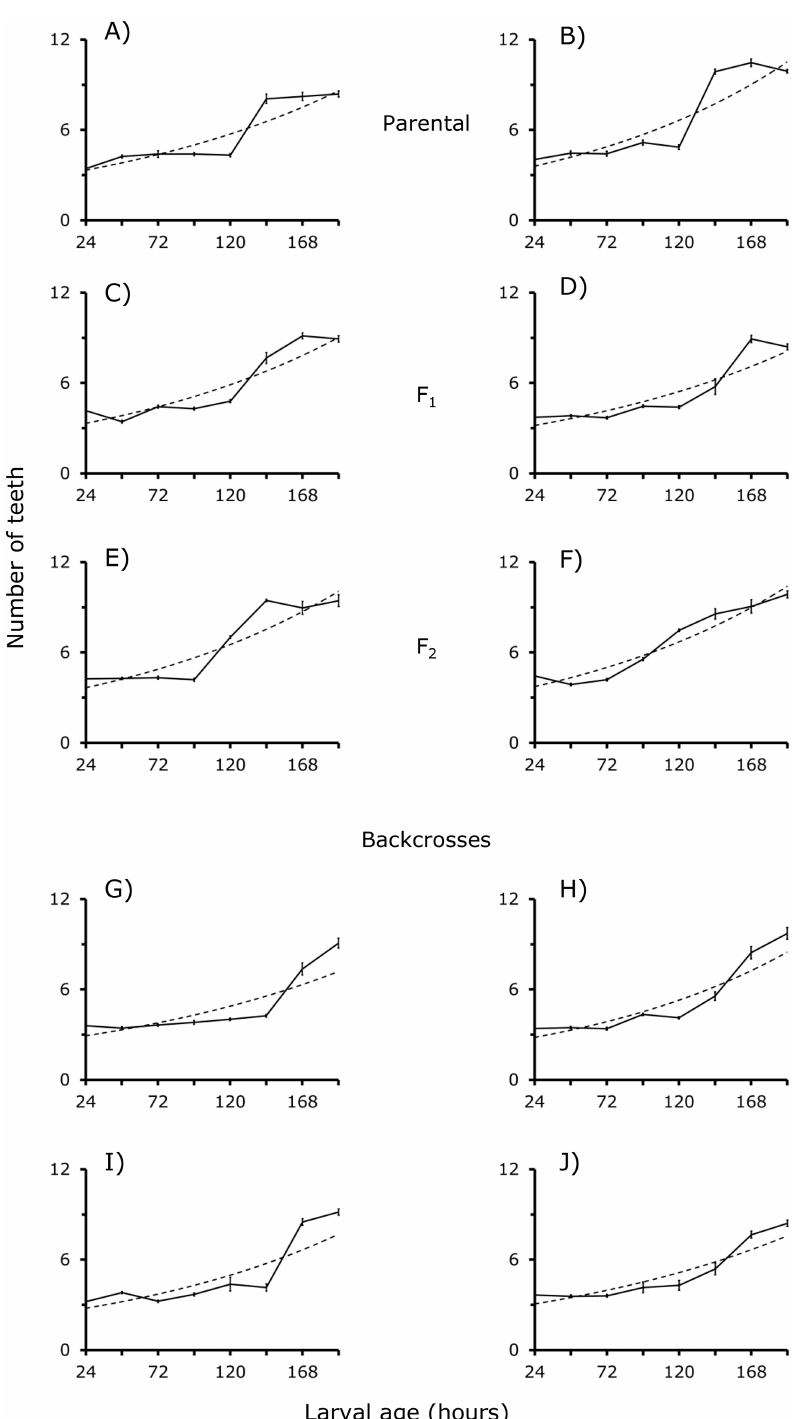
Fig 3. A–J. Number of mandibleteeth in BA (A), CJ (B), F 1 (C and D), F 2 (E and F) and backcross larvae(G to J) of D . gaucha .For further detailssee Fig 4 and Tables 2 and 3.